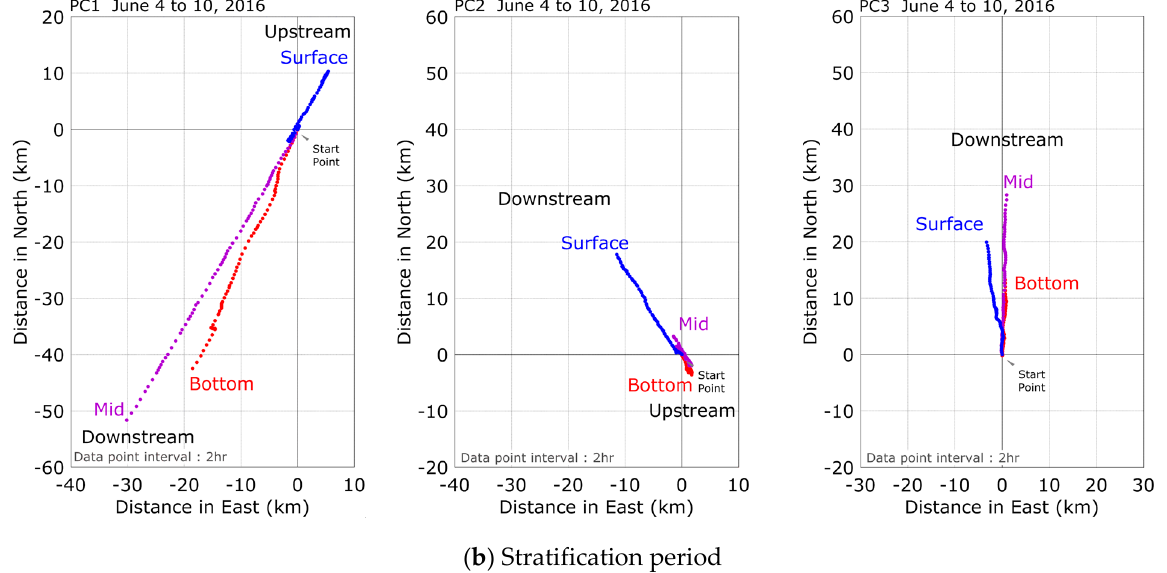
Figure 4. Velocity vectors for the different depth layers and periods.